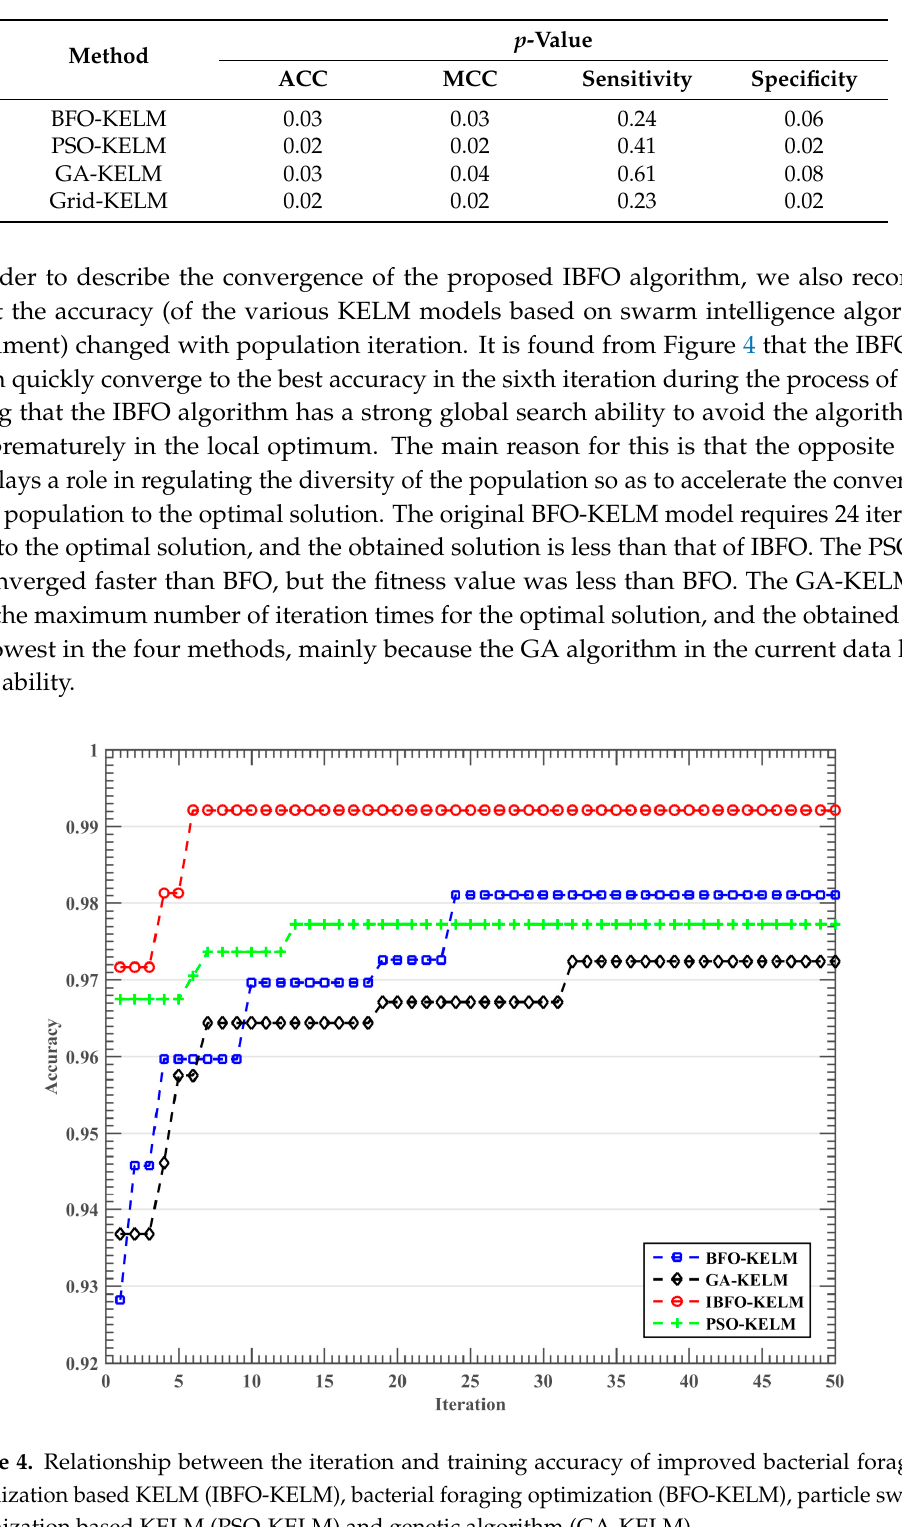
Table 6. p -values of the Wilcoxon test of IBFO-KELM results versus other four methods ( p > 0.05 are shown in bold).